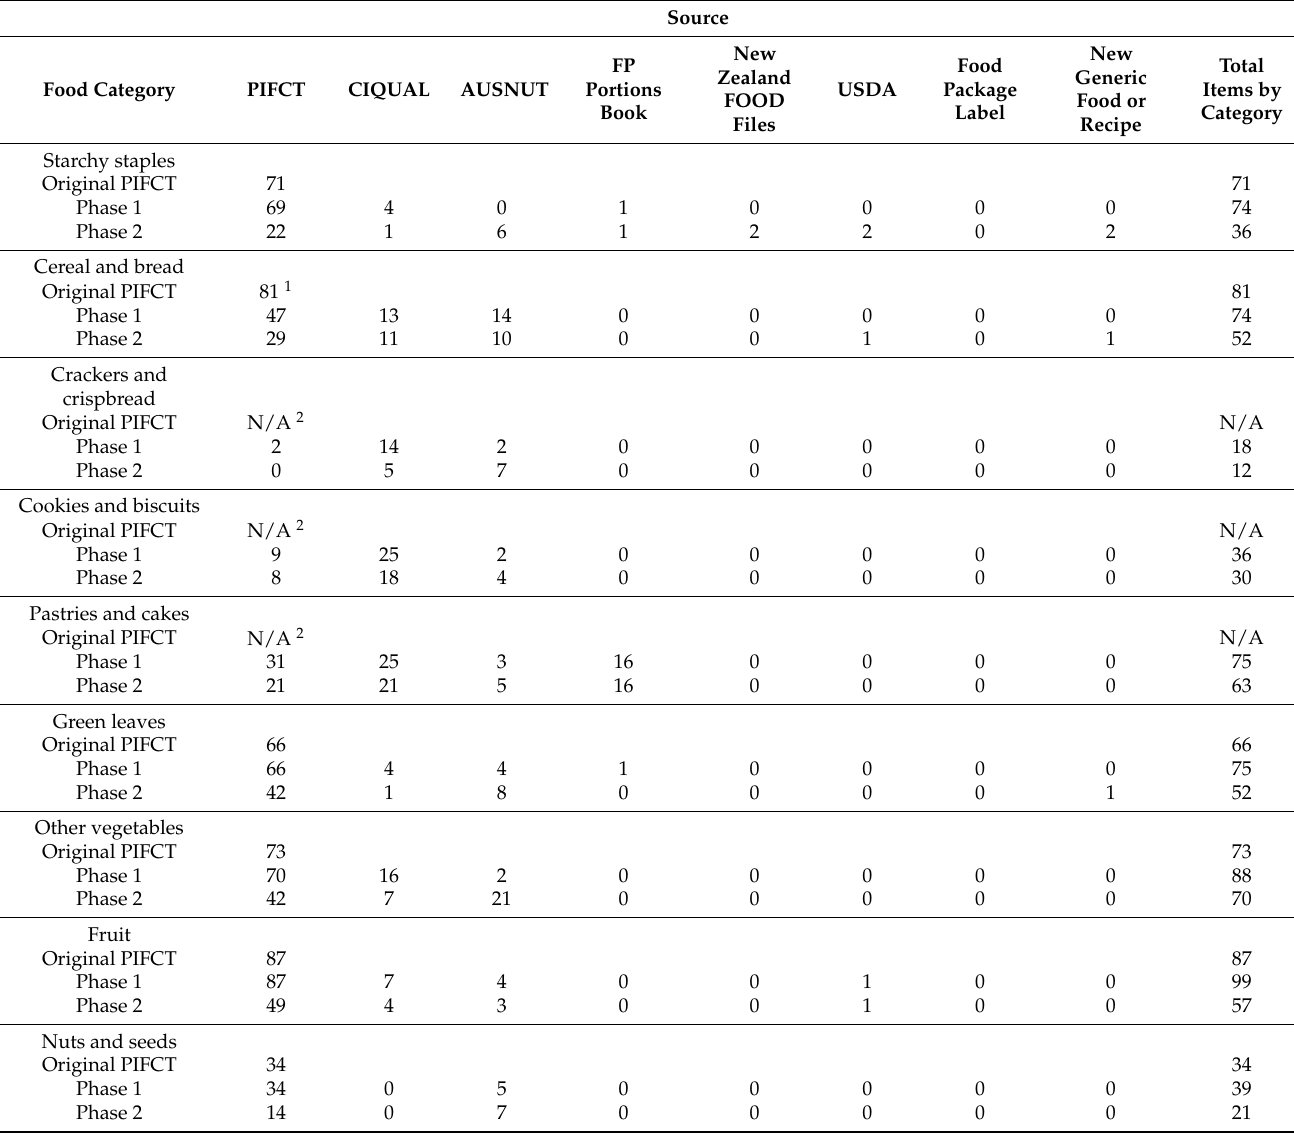
Table 1. Sources and categories of food items during the development phases of Version 1.0 of the New Caledonian food composition